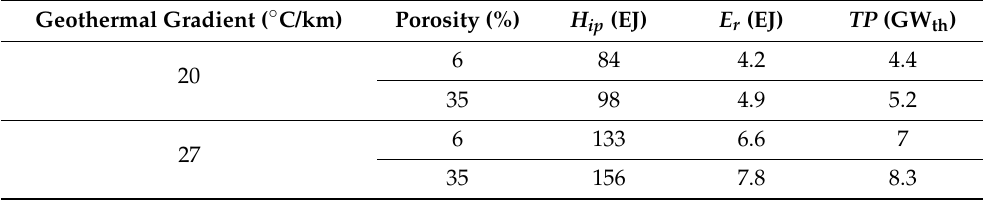
Table 6. Geothermal potential assessment for varying porosity values: 1 EJ = 1 × 10 18 J. Geothermal Gradient ( ◦ C/km) Porosity